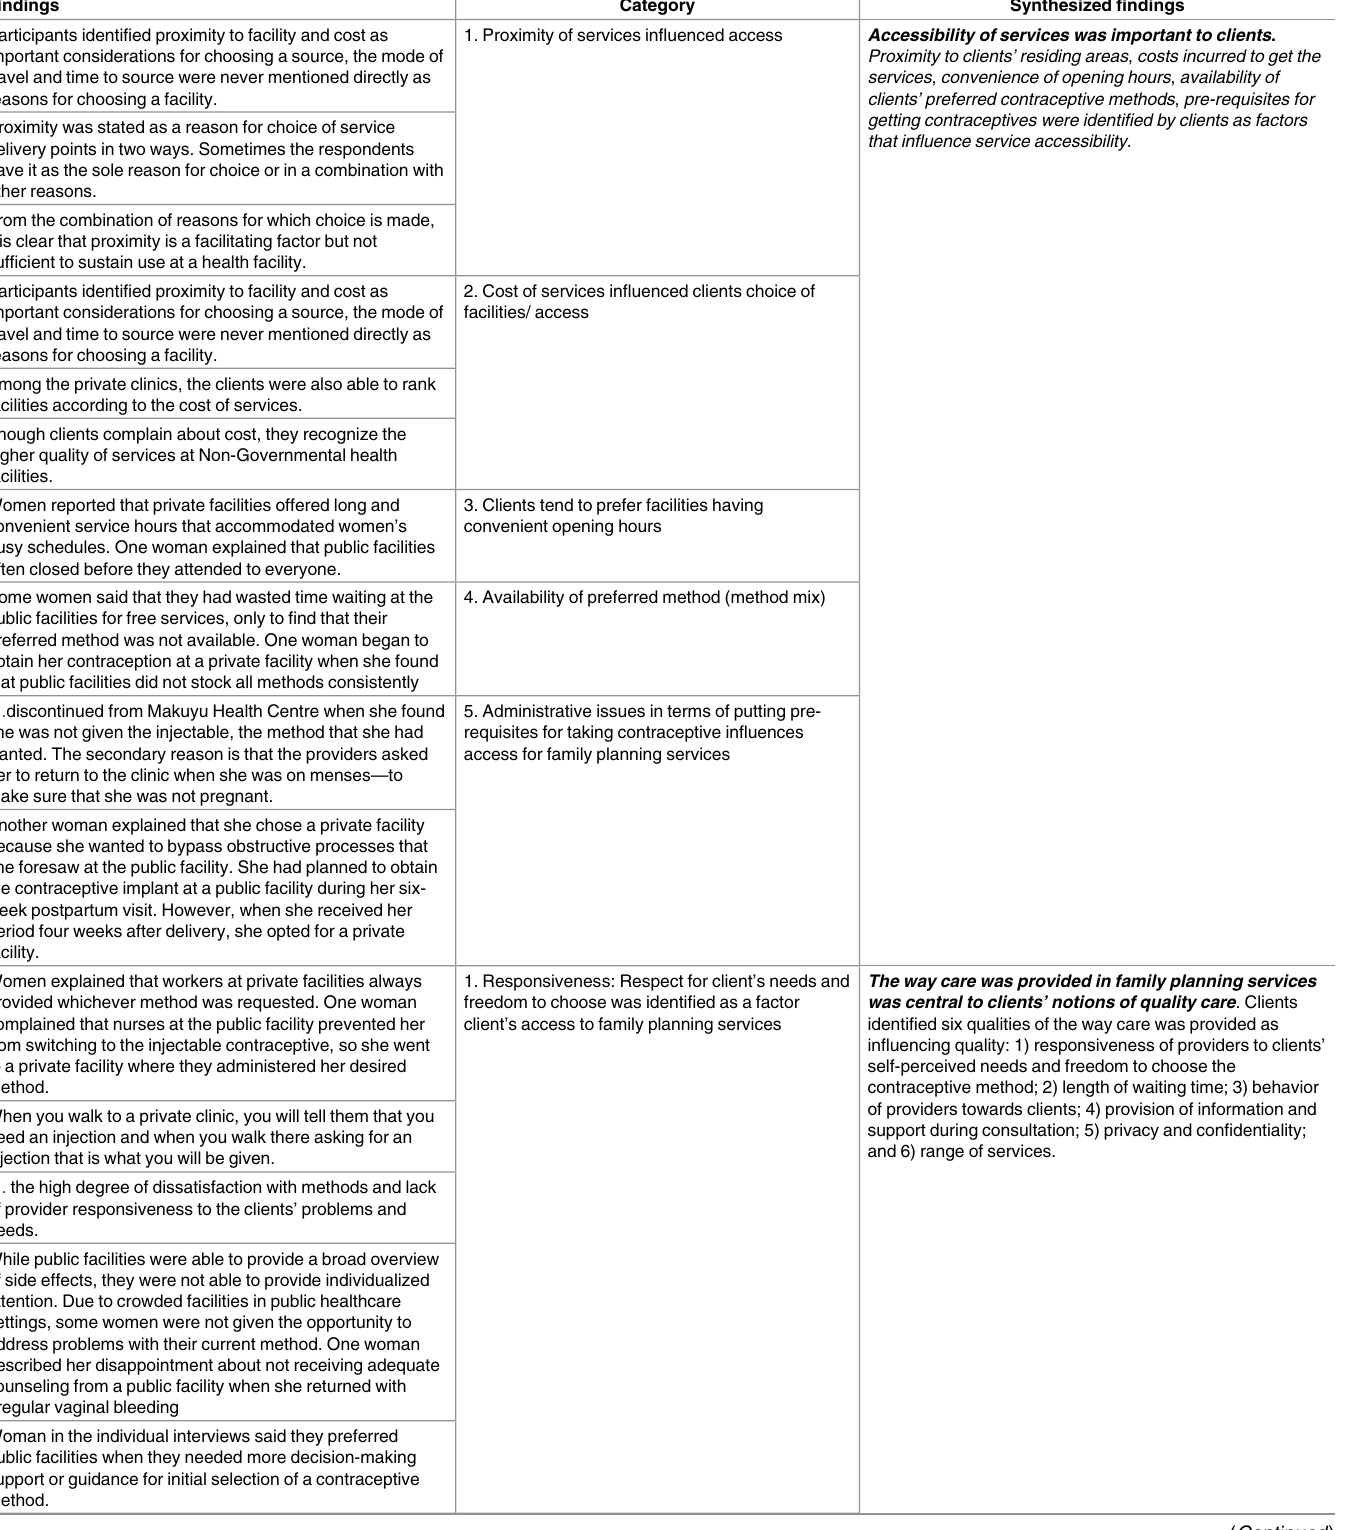
Table 4. Synthesis of qualitative findings on how clients perceive factors determining the quality of care in family planning services. Findings Category Synthesized